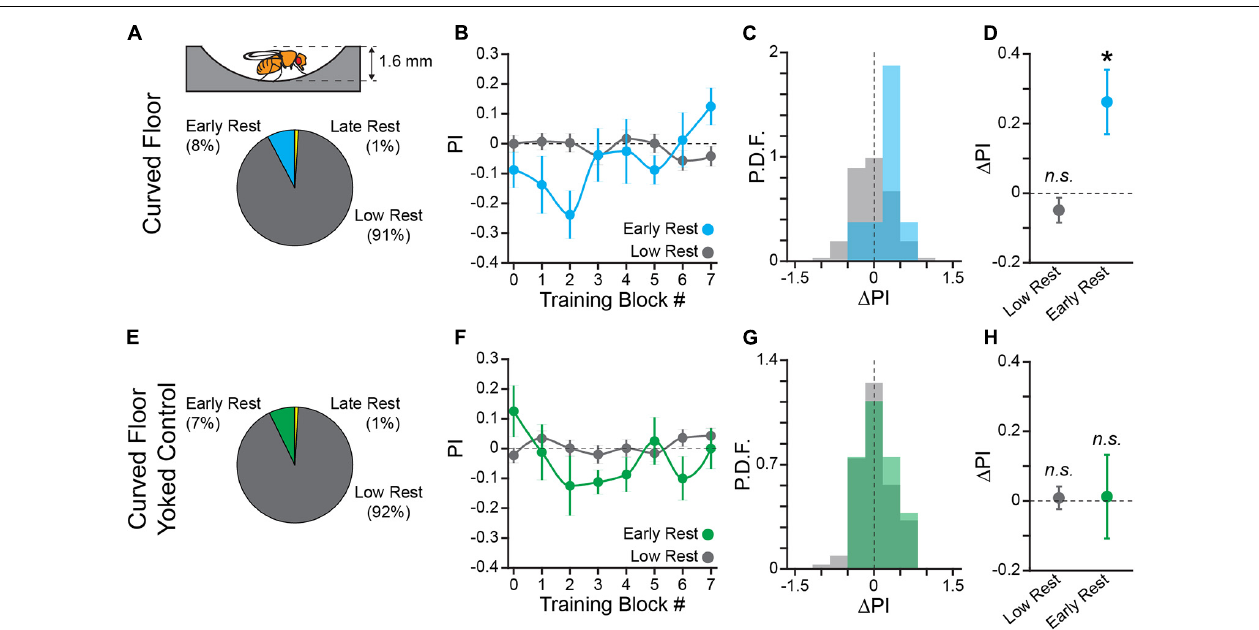
FIGURE 3 | Learning to turn toward sucrose is independent of track geometry but dependent upon an informative operant contingency. (A) Schematic of hallway geometry with representative fly for scale ( Top ), Fraction of flies with each rest phenotype ( Bottom ). (B,F) Mean turn direction Preference Index (PI) for each training block for trained (B) and yoked control (F) flies in the curved floor Y-Maze. Points plotted in color are flies with early rest (drowsy), points plotted in gray are flies with low rest (restless). (C,G) Probability Distribution Function (P.D.F.) histograms of change in turn preference index ( (cid:49) PI) between training block #1 and #7 for trained (C) and yoked control (G) flies. Drowsy flies are plotted in color ( cyan : trained, green : yoked), restless flies are plotted in gray. (D,H) Mean (cid:49) PI of low rest (restless) and early rest (drowsy) flies trained in curved floor Y-Maze (D) , and yoked control flies (H) . Error bars are standard error of the mean, n.s. : groups are not significantly greater than zero, * groups are significantly greater than